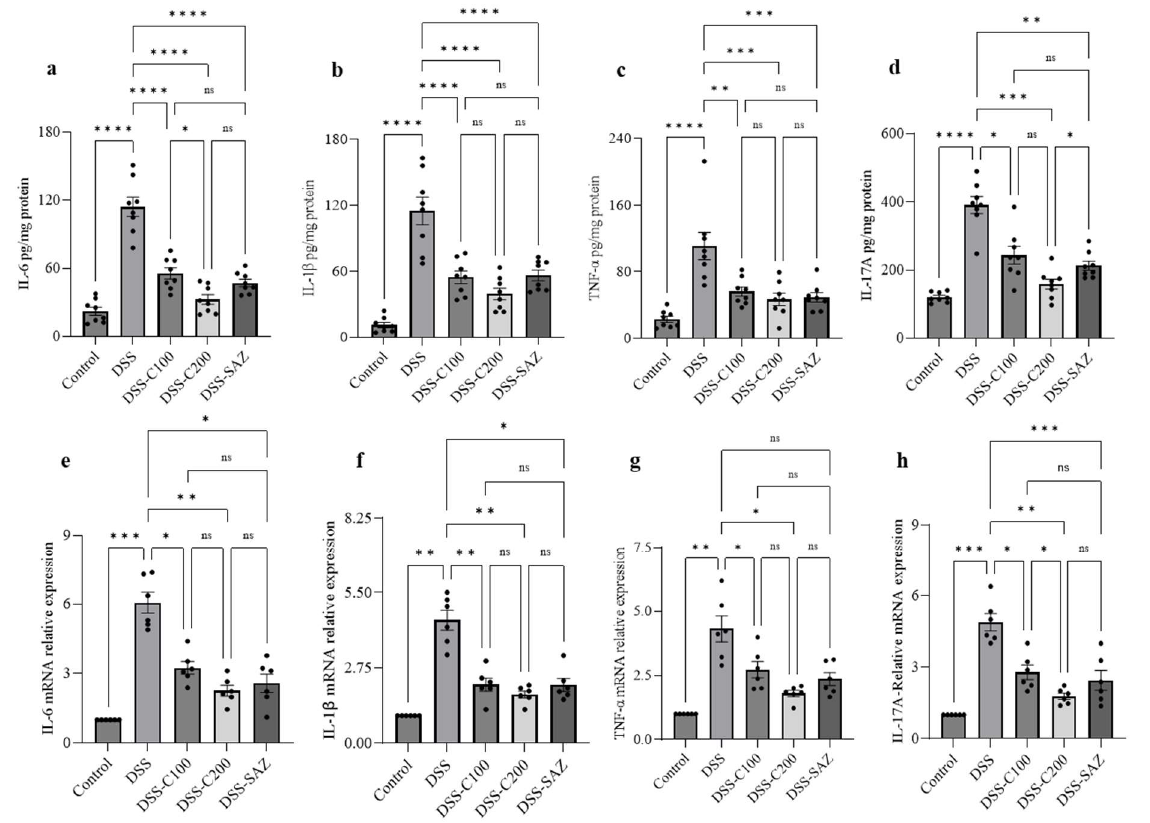
Figure 4. Effect of 1,8-cineole on proinflammatory cytokine protein and mRNA expression. ( a – d ) DSS administration significantly increased colonic proinflammatory cytokine levels. 1,8-cineole treatment significantly prevented the increase in proinflammatory cytokines. ( e–h ) Similarly, DSS administration significantly increased the expression of proinflammatory cytokine mRNA levels. 1,8-cineole treatment significantly prevented this increase in expression of proinflammatory cytokine mRNA. Data were obtained from n = 8 animals per group. The results are expressed as the